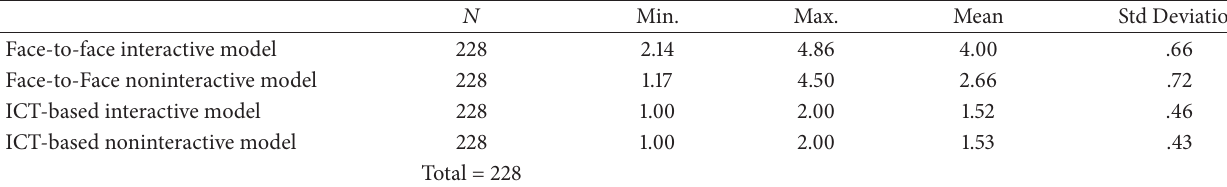
Table 2: Descriptive statistics on the various models of supervision.